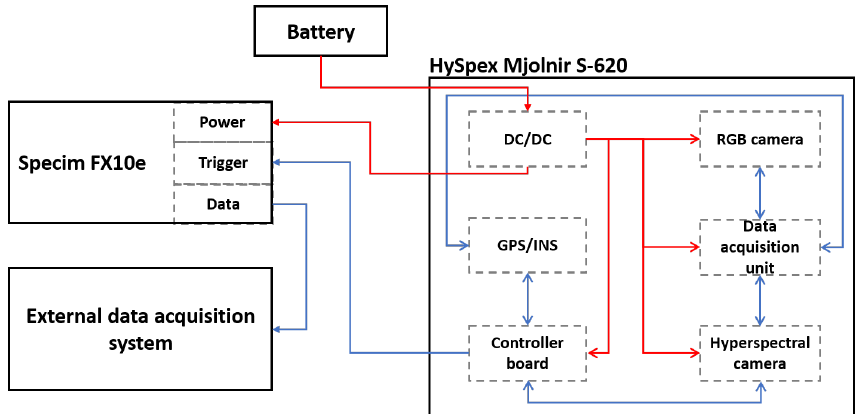
Figure 3. Connections between the hyperspectral cameras, data acquisition computers and